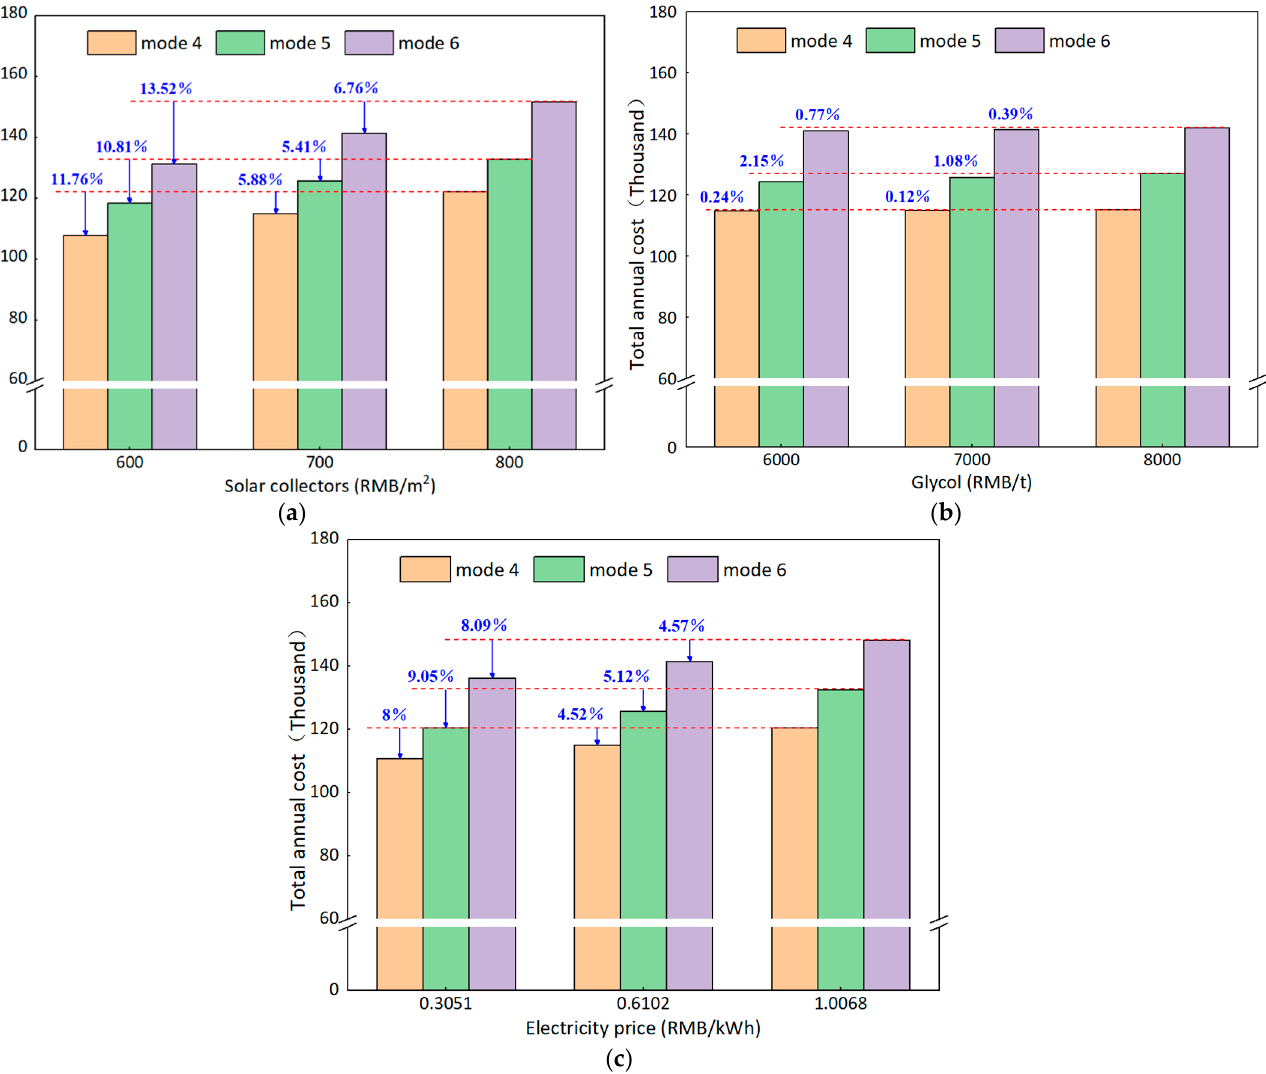
Figure 7. ( a ) The impact of solar collectors price on the total annual cost ; ( b ) the impact of glycol price on the total annual cost ; ( c ) the impact of electricity price on the total annual